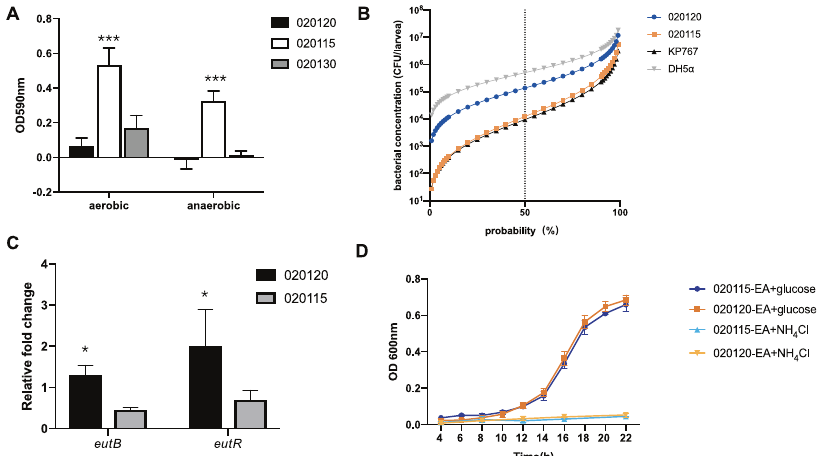
Fig. 4 Bio fi lm formation, virulence assays, qRT-PCR, and ethanolamine utilization results. A Bio fi lm formation of C1_020120, C2_020115, and 020130. Absorption values of strains C1_020120, C2_020115, and 020130 (the closest strain of clone 1) at both OD 590 nm are shown. B Survival of G. mellonella after infection by bacterial strains. The effect of 1 × 10 3 , 1 × 10 4 , 1 × 10 5 , and 1 × 10 6 CFU of each strain on survival of G. mellonella at 72 h after infection is shown. KP767, a hypervirulent K. pneumoniae , was used as a positive control, while E. coli DH5 α was used as a negative control. C qRT-PCR for eutB (encoding the ethanolamine ammonia-lyase heavy chain) and eutR (encoding an HTH-type transcriptional regulator) genes for strain C1_020120 and C2_020115. Values are the mean ± standard deviation (SD). * p < 0.05. D utilization of ethanolamine (EA) as a sole carbon (adding NH 4 Cl) or nitrogen (adding glucose) source. C1_020120 and C2_020115 were able to use ethanolamine as a nitrogen source but not a carbon